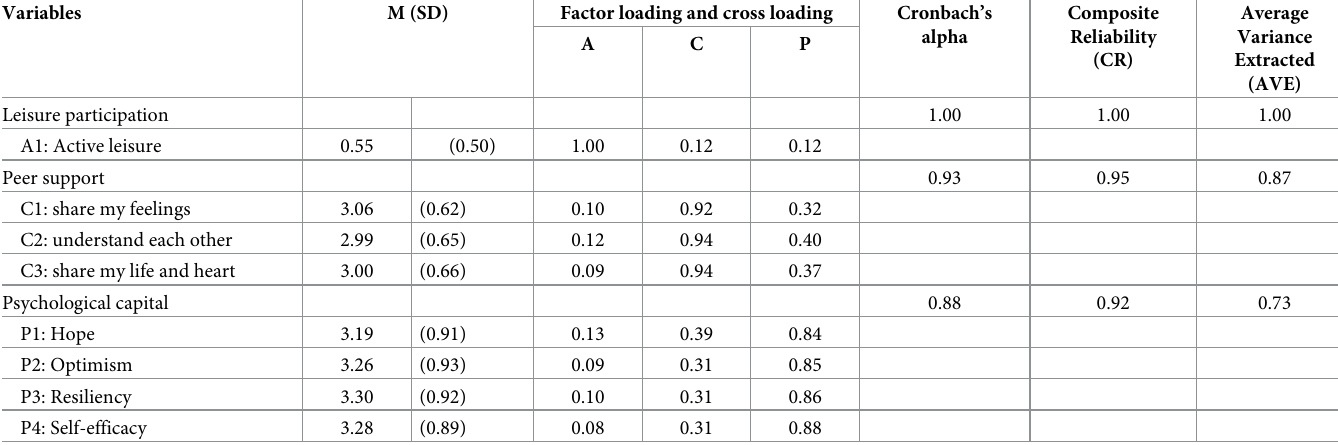
Table 2. Quality criteria: Factor loading, cross loading, discriminant validity, construct reliability and validity.